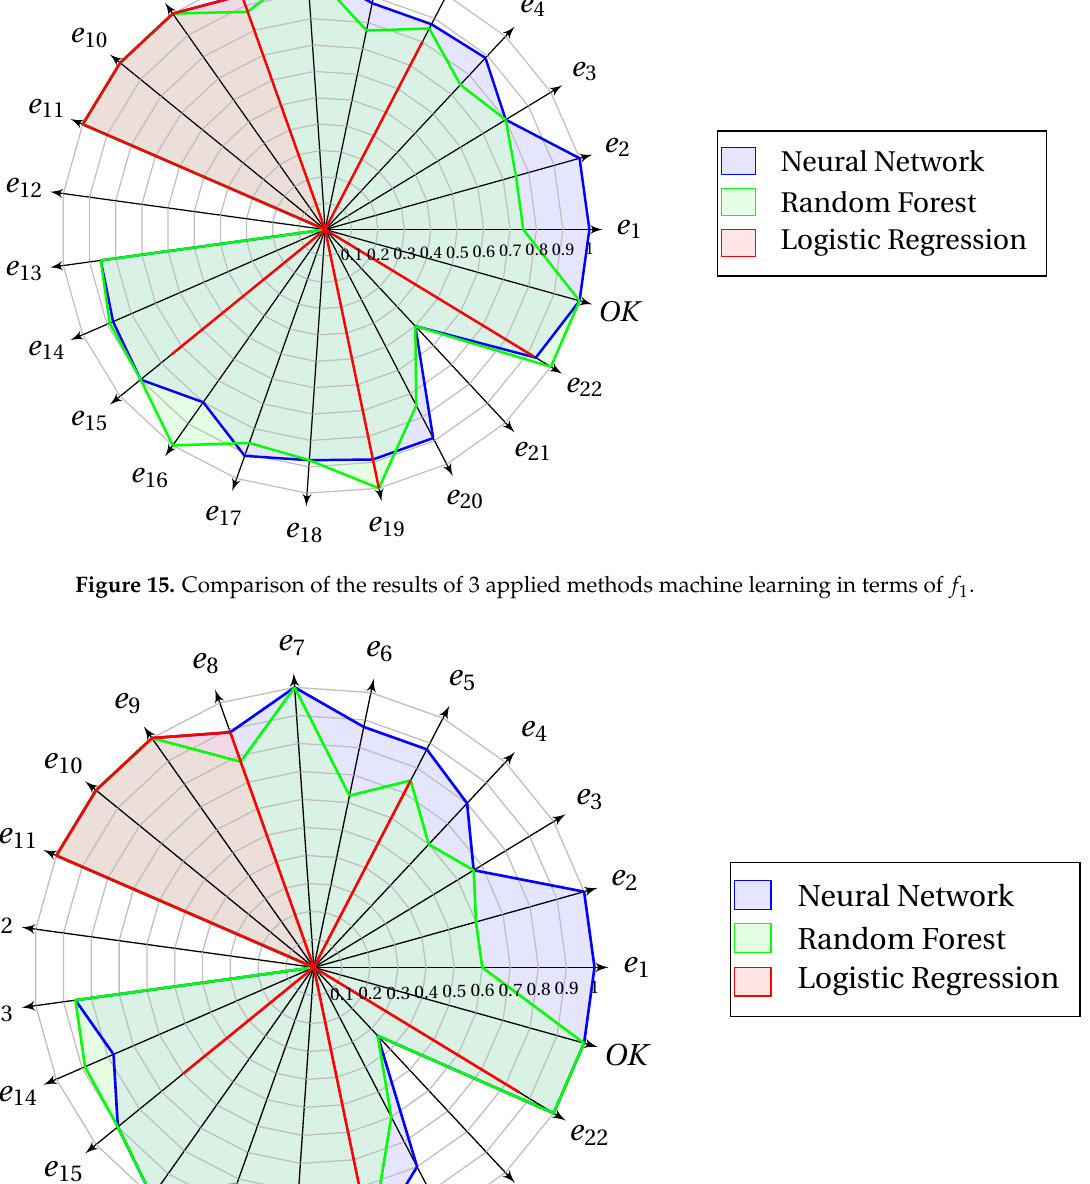
Figure 16. Comparison of the results of 3 applied methods machine learning in terms of AUC Figure 12. Comparison of the results of 3 applied methods machine learning in terms of recall.